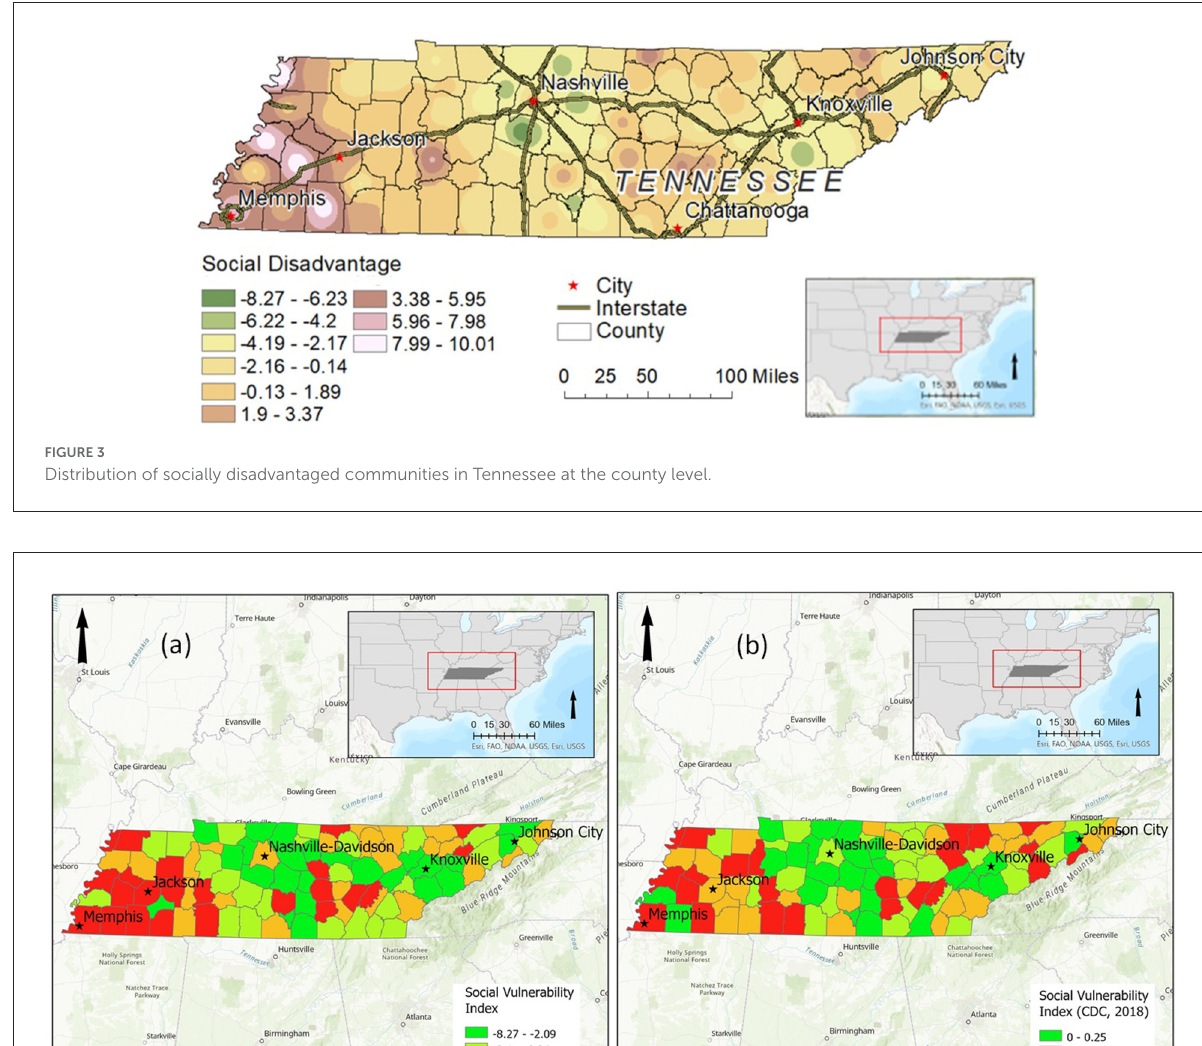
CFR, or the ratio of the total confirmed cases to